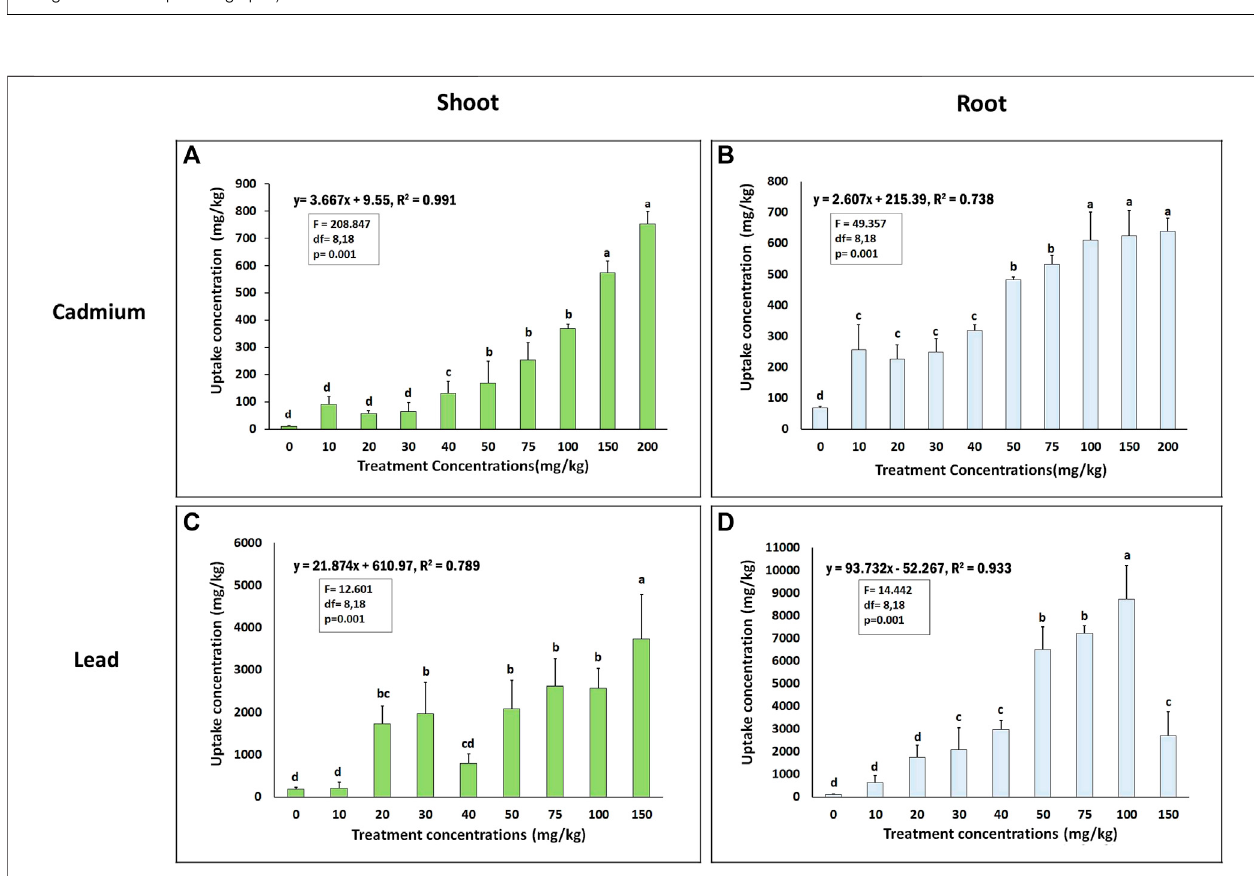
FIGURE 4 | Heavy metal uptake by roots and shoots of Cleome rutidosperma recorded in pot experiments under different treatment concentrations of (A) and (B) cadmium, (C) and (D) lead in shoots and roots, respectively. The bars marked with different alphabets (a,b,c,d) are signi fi cantly different from each other (F values and “ df ” are given in the respective graphs). R 2 represents the correlation between the content of metal in root – shoot tissues versus the soil at p ≤ 0.05.